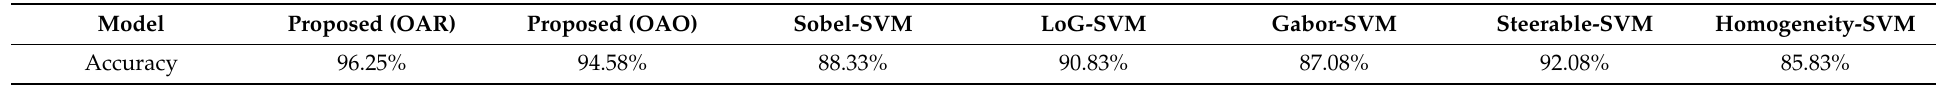
Table 22. Diagnosis accuracy comparison between proposed methods and independent SVMs with single-type of features.